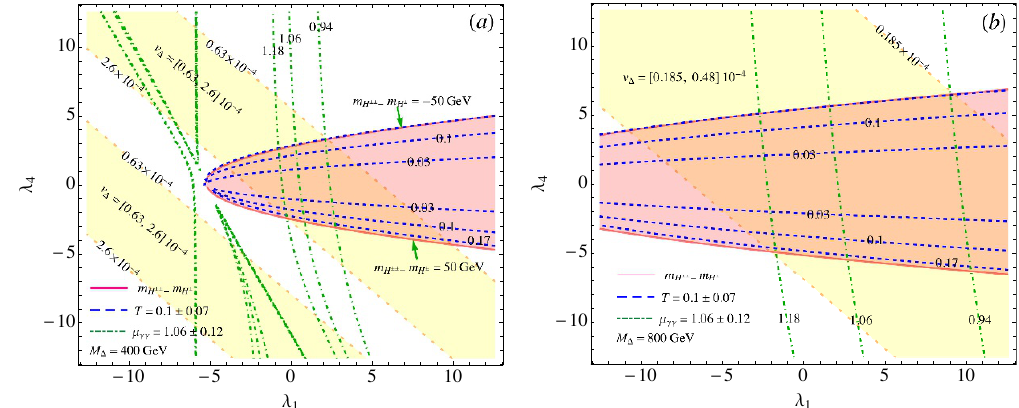
Figure 9 . Constraints from the oblique T -parameter (dashed) and the h ! (cid:13)(cid:13) (dot-dashed) precision measurement, where (a) [(b)] corresponds to the case with M (cid:1) = 400[800] GeV and (cid:22) (cid:1) = 4 : 8 (cid:2) 10 (cid:0) 4 GeV. The area enclosed by the solid line denotes m